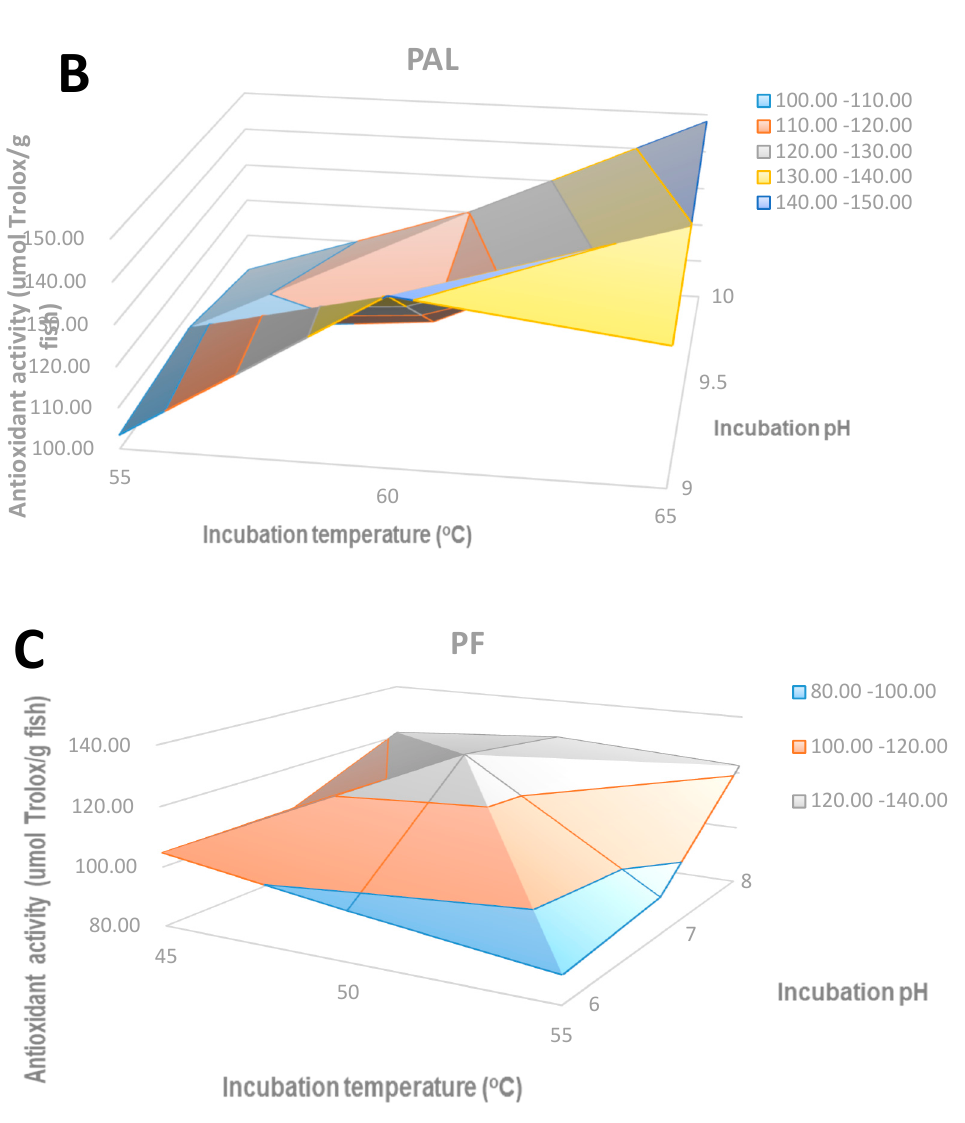
Figure 2. The antioxidant activity of hydrolysates by the ABTS method: ( A ) HT hydrolysate; ( B ) PAL hydrolysate; ( C ) PF hydrolysate .